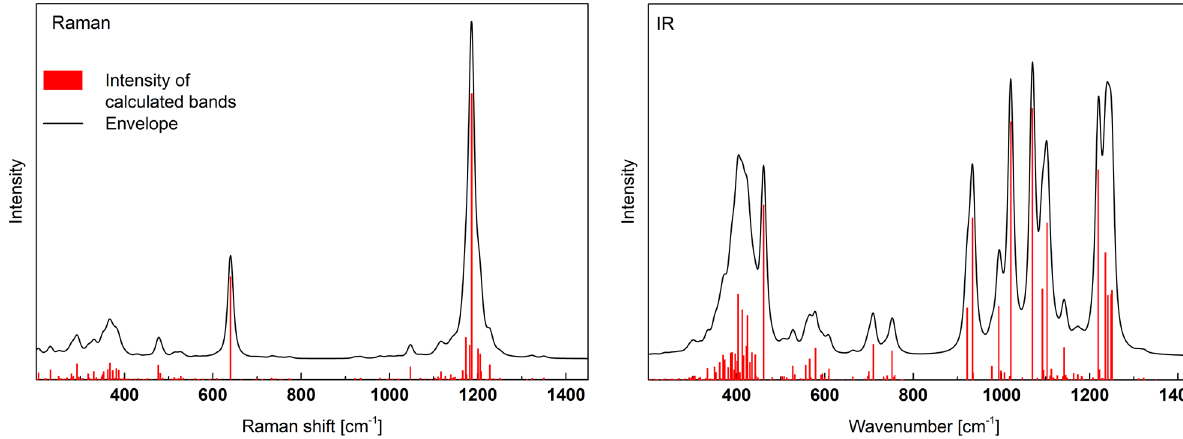
Figure 5. Calculated Raman and IR spectra of B-Al(PO 3 ) 3 .